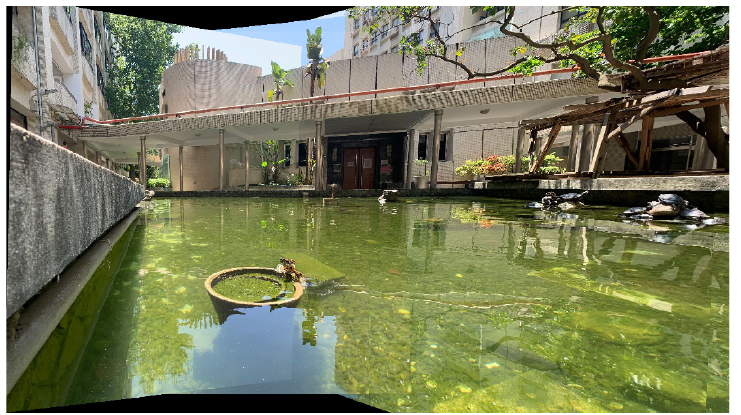
Figure 19. The picture obtained by synchronous stitching in actual navigation according to the feature method.